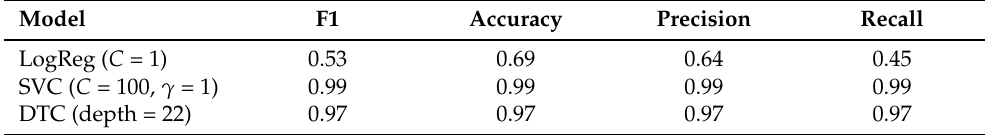
Table 6. Accuracy of evaluated classification models. Optimized hyperparameters are in